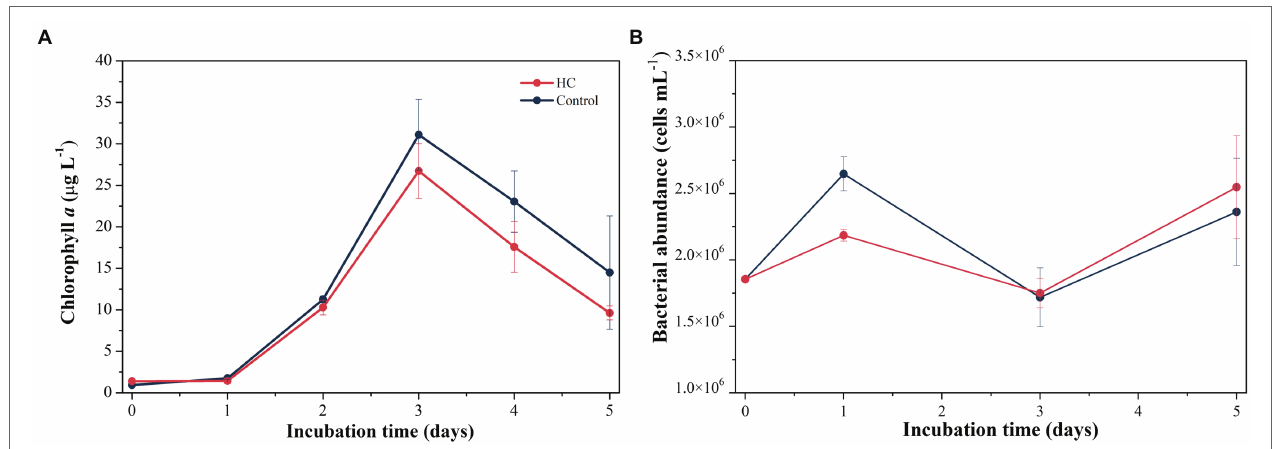
FIGURE 2 | Changes in Chl a concentration (A) and total bacterioplankton abundance (B) during incubation under elevated p CO 2 (HC, about 1,000 μ atm) or ambient p CO 2 (Control, about 380–410 μ atm) conditions in microcosm experiment. Error bars indicated SD of replicate